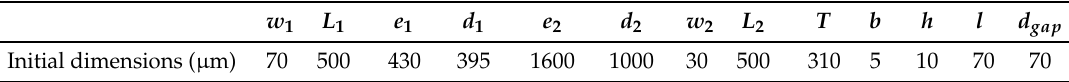
Table 1. The initial geometrical dimensions.